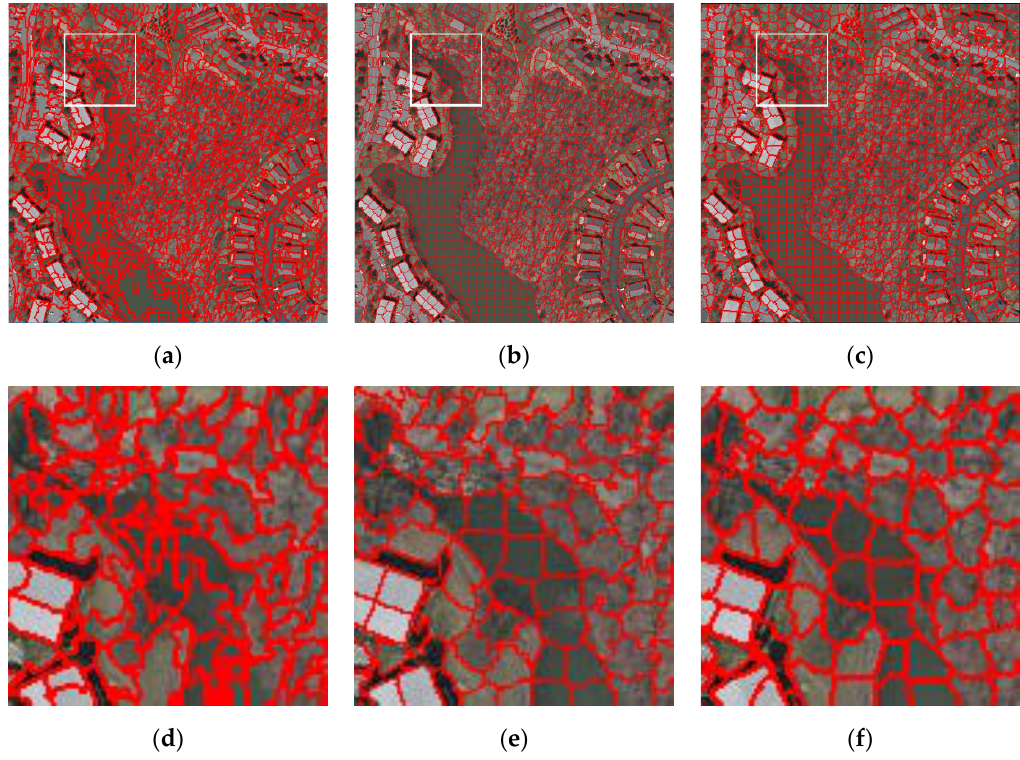
Figure 8. Initial superpixels result: ( a ) EGB superpixels; ( b ) SLIC superpixels; ( c ) gSLICr superpixels; ( d – f ) Local magnification superpixels of EGB, SLIC, and gSLICr.